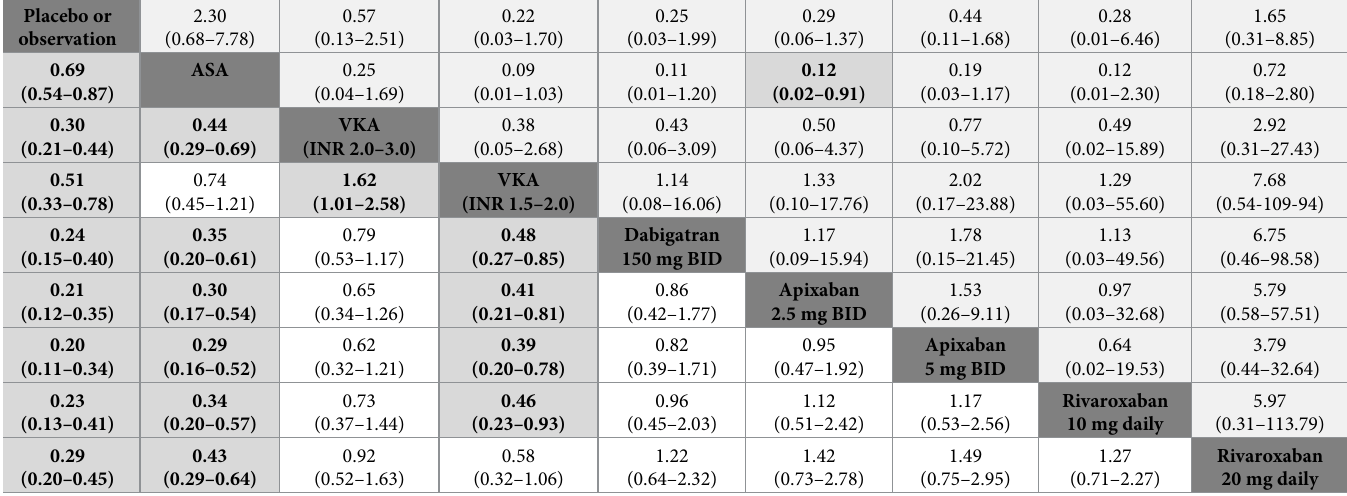
Relative risks for net clinical benefit are below the diagonal line (row defining the experimental group, column defining the placebo/observation group), whereas relative risks for fatal outcomes due to recurrent venous thromboembolism or major bleeding are above the diagonal line (row defining placebo/observation group, column defining the experimental group). Significant results are presented in bold/light grey. Data for non-commercialized drugs (idraparinux, sulodexide, and ximelagatran) are provided in S5 Table. ASA: ASPIRIN; BID: TWICE DAILY; VKA: VITAMIN K